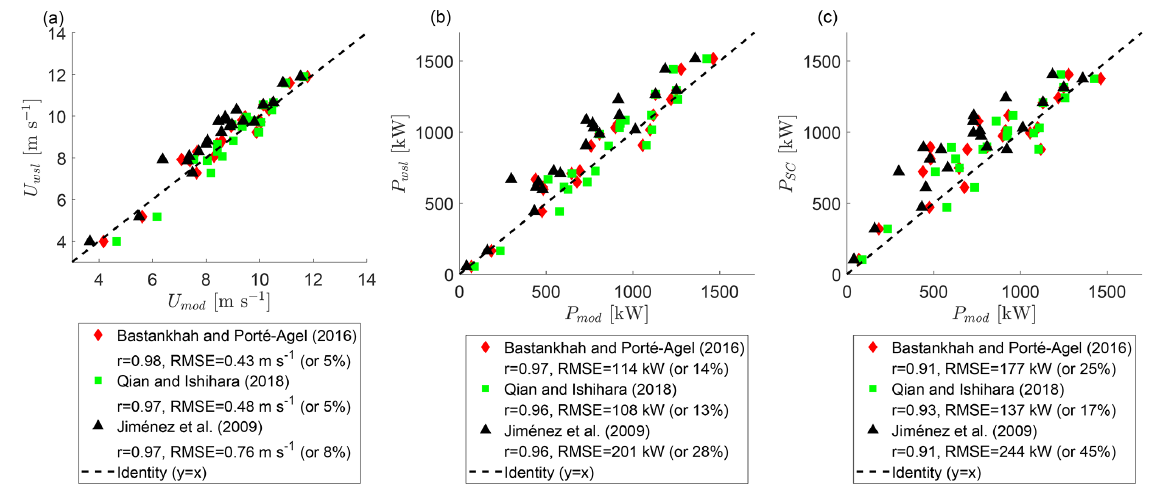
Figure 11. The rotor-averaged velocity prediction of the analytical models for T3 compared with the measurements by wake-scanning lidar (a) . The power prediction of the analytical models for T3 compared with the wake-scanning lidar (b) and the SCADA data (c) . Data of the wake-steering cases with a 3D scan of wake-scanning lidar and a model prediction at x/D = 4 are used. Red diamonds show the Bastankhah and Porté-Agel (2016) model, green squares show the Qian and Ishihara (2018) model, black triangles show the Jiménez et al. (2009) model, and the dashed black line is the